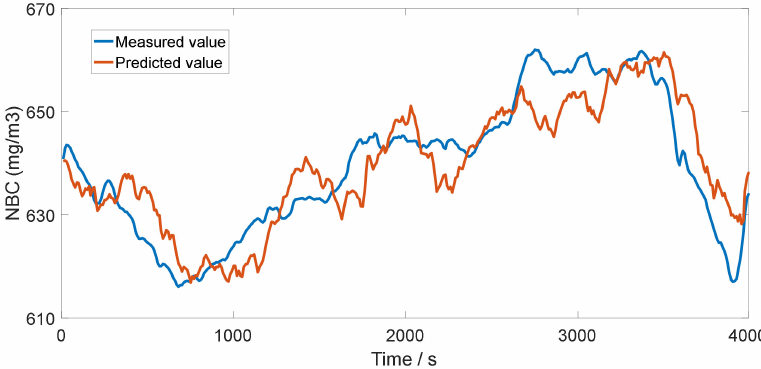
Figure 4. Trend of actual and predicted NO X value of 12,000 t / d production